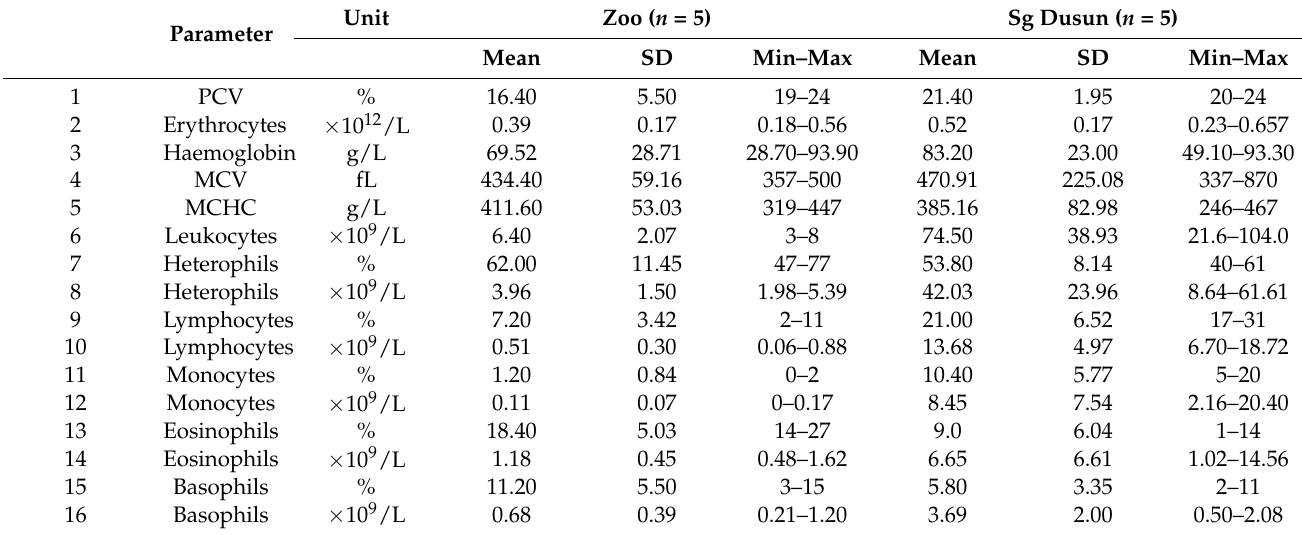
Table 7. Comparison of the Hematological Profile between Two Environments. For each parameter the mean and the standard deviation (SD), as well as the minimum (Min) and maximum (Max) range are reported.